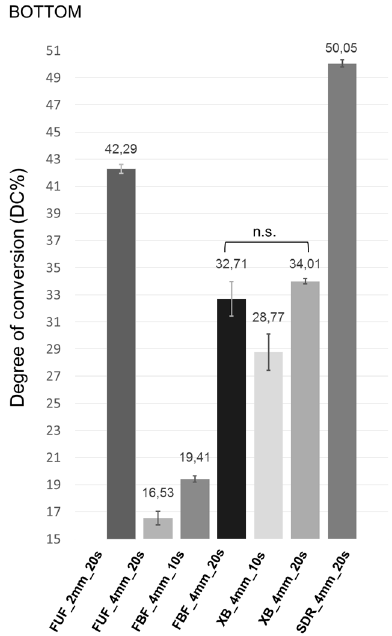
Figure 2. Mean DC% and 95% confidence intervals of the bottom surface of the samples